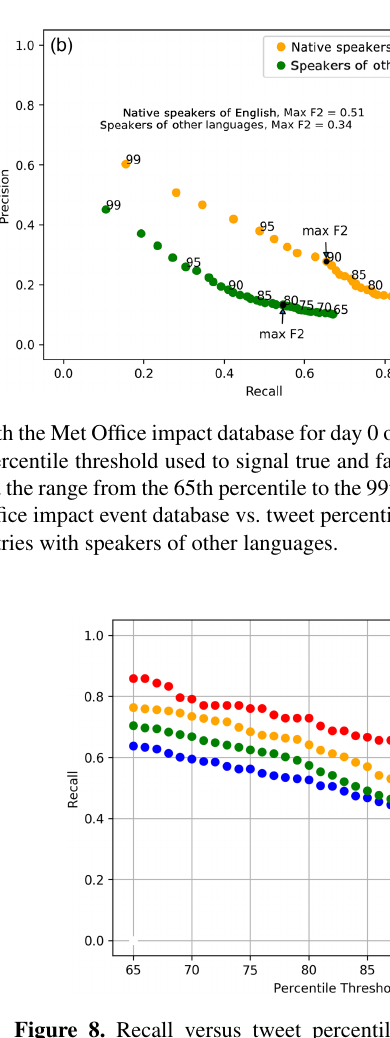
Figure 8. Recall versus tweet percentile threshold for matches (within 3d of event) to the Met Office impact event database for each category of impact severity (where impact severity category 4 represents the most impactful